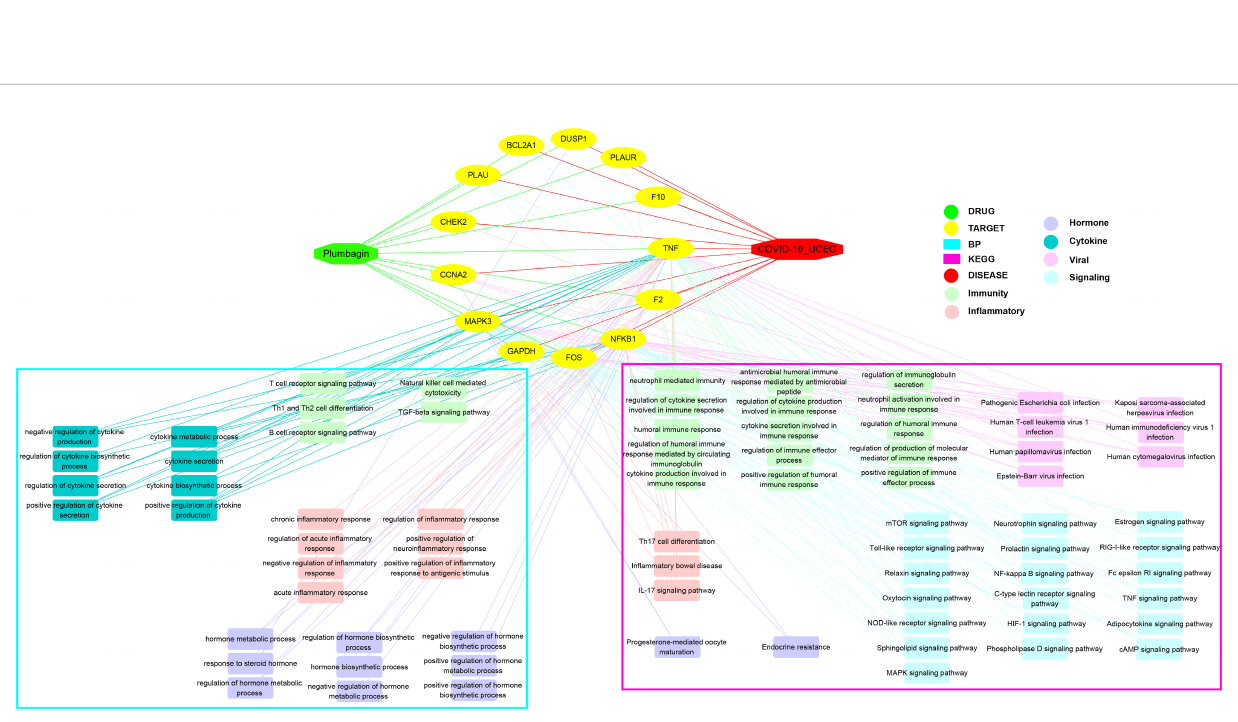
Frontiers in Endocrinology |